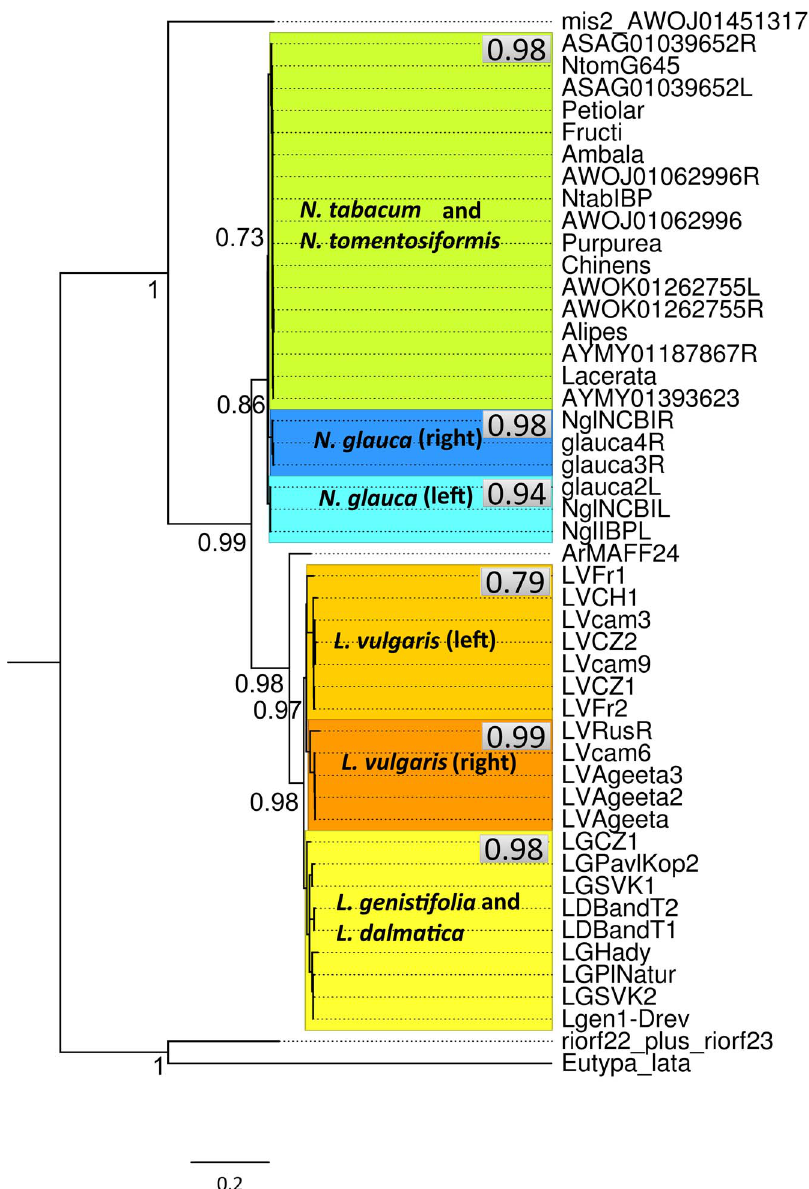
Figure 2. Maximum-likelihood analyses of the region containing gene for mikimopine synthase and the ORF14 gene in A. rhizogenes and their plant homologues in N. glauca . The clades belonging to individual plant species are marked in colour. If left and right copy were present they are also distinguished by colour. The support values (aLRT) are not shown for the nodes inside the marked blocks. Support value for each marked block is shown inside the grey rectangle in the right upper corner of this block. For the support values and the topology inside the marked blocks see Figure S2A.